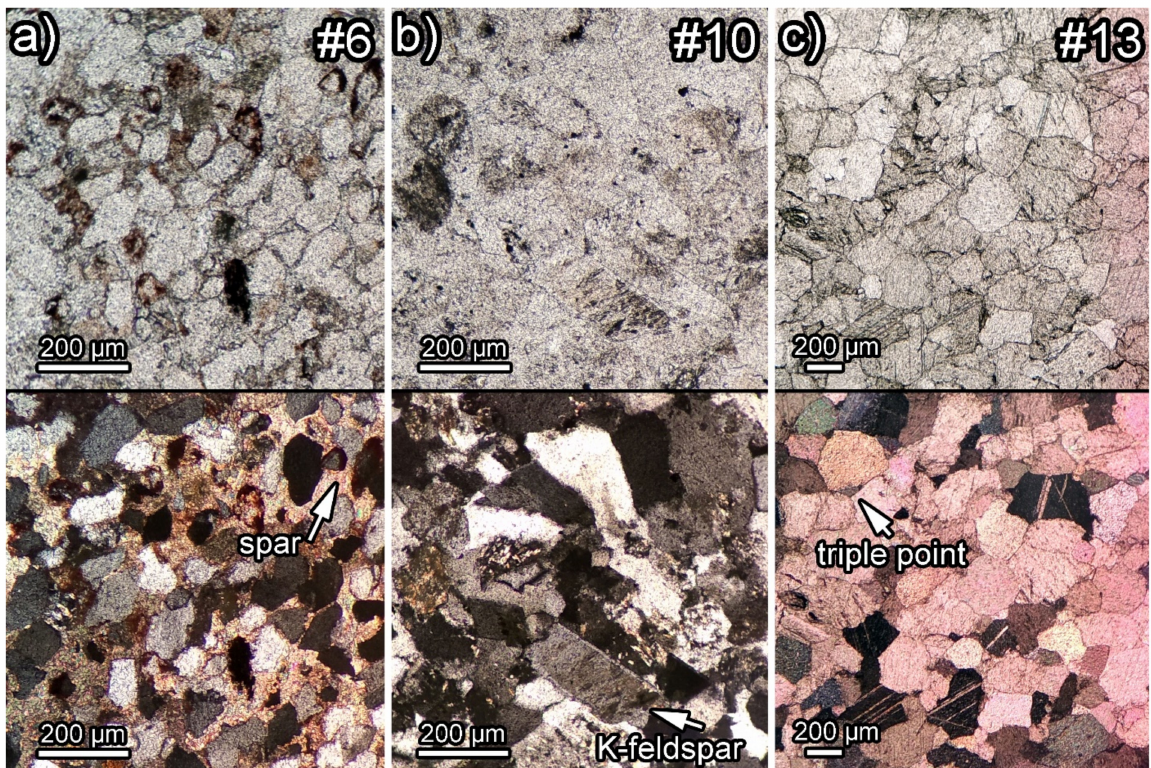
Figure 3. POM images of thin sections of some sampled stone tesserae from the Circus mosaic including the same area viewed under PPL ( top ) and XPL ( bottom ): ( a ) Sandstone #6; ( b ) sandstone #10; ( c ) marble #13 with a red band corresponding to a positive alizarin red S